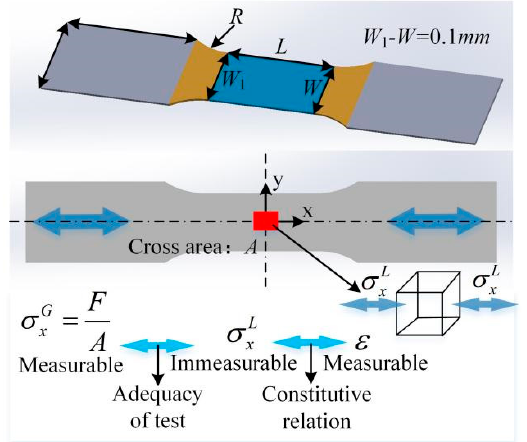
Figure 4. Geometrical parameters of the sample for in-plane compression test and schematic illustration of the difference between mean stress σ (cid:2934) ( (cid:2891) ) and local stress σ (cid:2934) ( (cid:2896) ) .